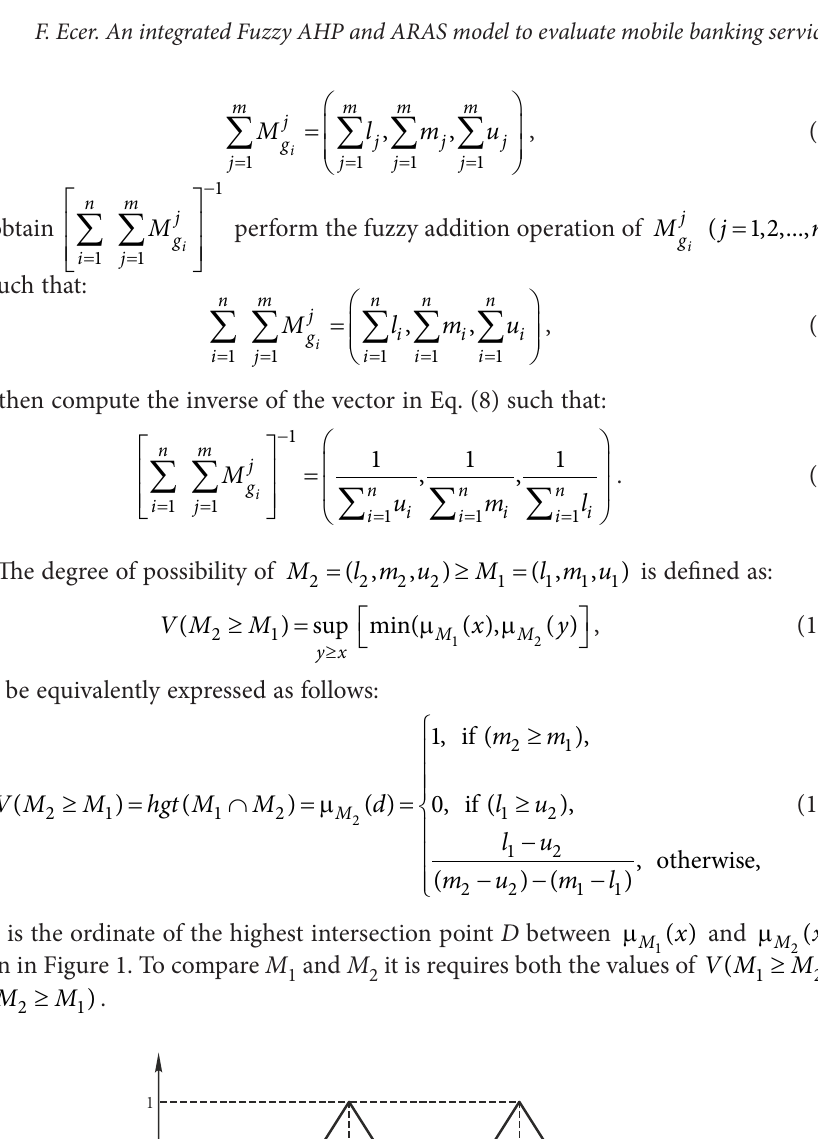
Fig. 1. The intersection between M Source : Aghdaie et al.